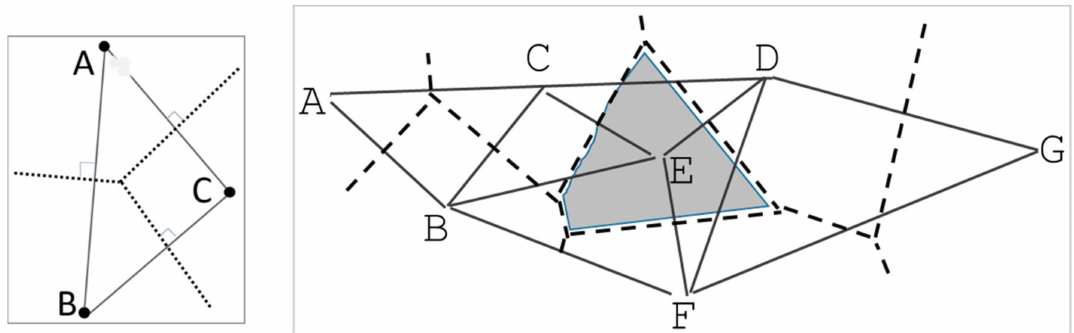
Figure 2. Construction of grid supply point (GSP) areas using Thiessen